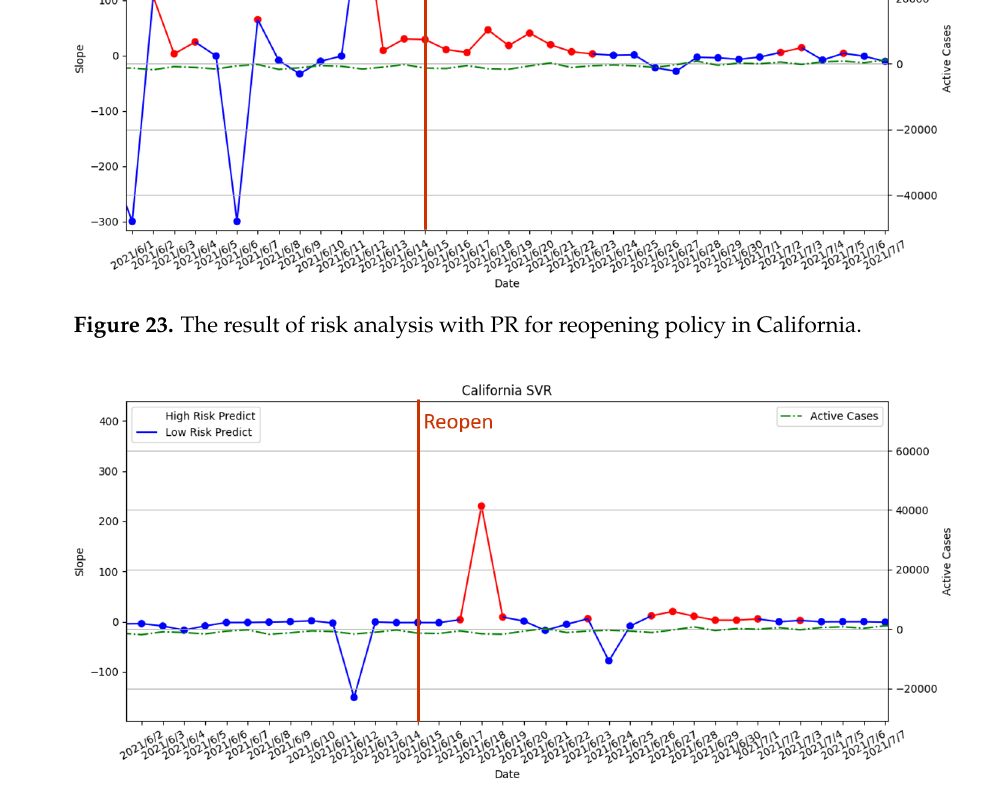
Figure 24. The result of risk analysis with SVR for reopening policy in